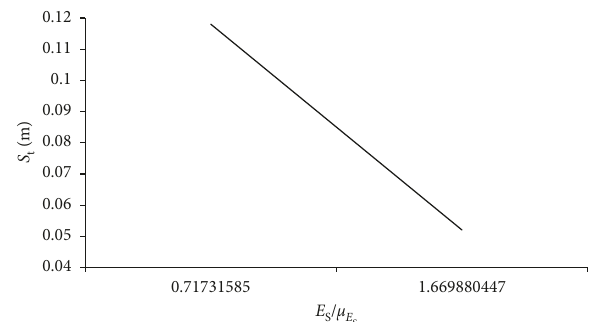
Figure 5: Effect of compressive modulus on final consolidation settlement.